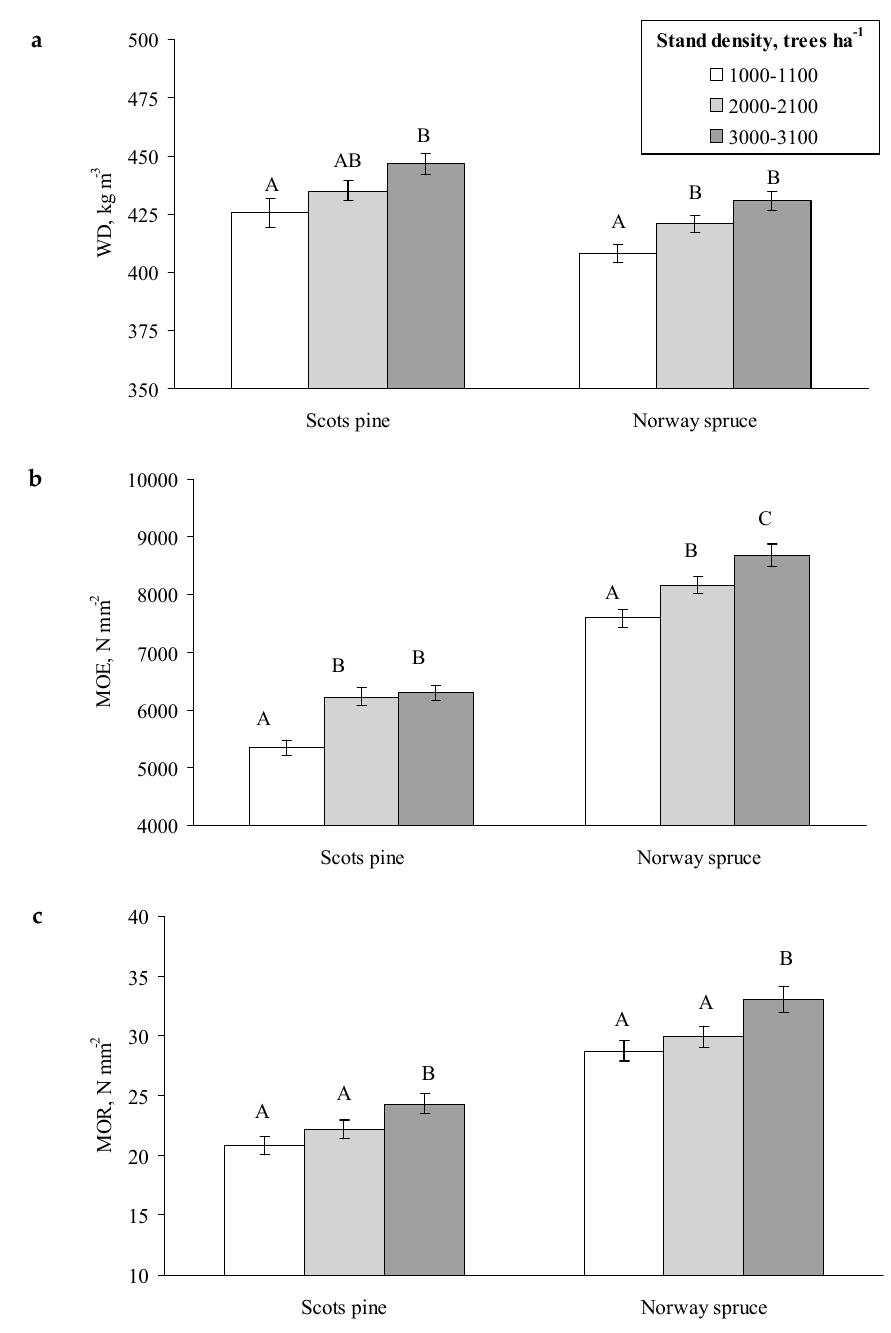
Figure 2. Mean values of wood density (WD) ( a ), global modulus of elasticity (MOE) ( b ), and bending strength (MOR) ( c ) at the sites with di ff erent stand densities. Bars show the std. error of the mean. Di ff erent capital letters at the top of the columns show statistically significant di ff erences between the sites at p <